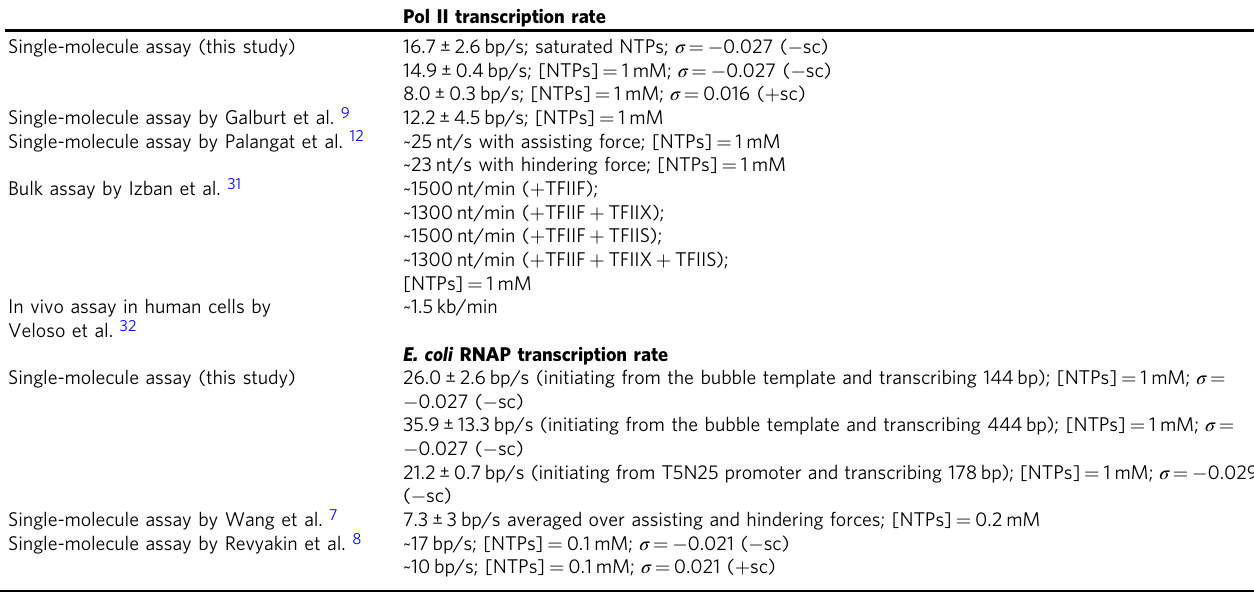
Table 1 Comparison of Pol II transcription rates measured in this and other studies Pol II transcription rate Single-molecule assay (this